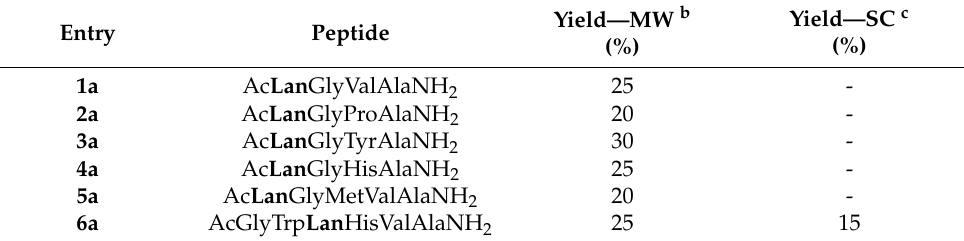
Table 1. Efficiency of the S-alkylation reaction to introduce lanthionine in peptides a